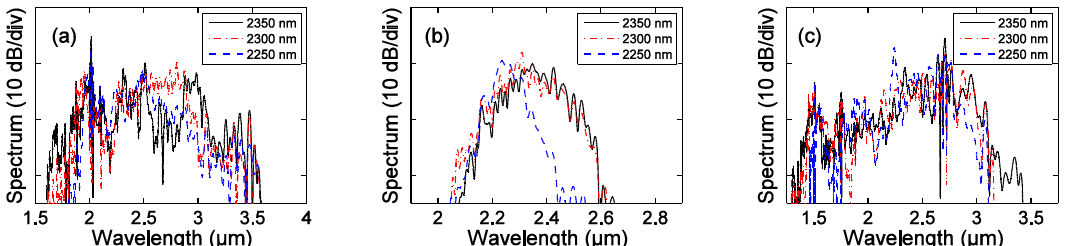
Figure 12. Evolution of experimental SC spectra recorded as a function of pump wavelength for a fixed input peak power of ~2.5 kW for 12-cm-long segments of tellurite step-index fiber with a distinct core diameter, namely ( a ) 3.5 µm, ( b ) 3µm, and ( c ) 4 µm.